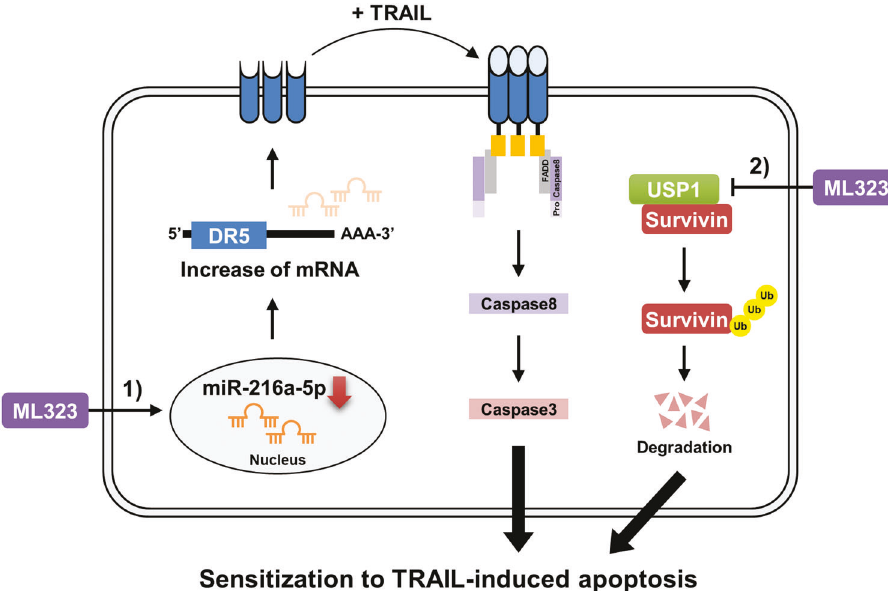
Fig. 9 Schematic representation of the mechanism of sensitization to anticancer drugs by USP1 depletion. Two signaling pathways are involved in ML323-mediated TRAIL sensitization. (1) ML323 decreases miR-216a-5p expression at the transcription level, stabilizes DR5 mRNA, and increases DR5 expression on cancer cell surface. (2) USP1, highly expressed in renal cancer, interacts with survivin and induces deubiquitination of survivin. When USP1 is inhibited by ML323, survivin is ubiquitinated and degraded. Eventually, sensitivity of TRAIL is increased by upregulation of DR5 and downregulation of survivin in ML323